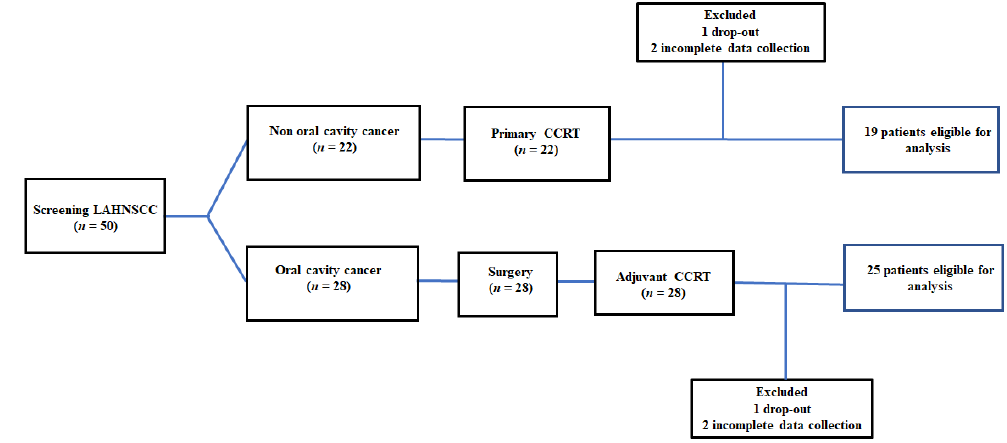
Figure 1. The flow diagram of recruitment: The incomplete CCRT group was defined as (1) patients who dropped out during the treatment course; and (2) incomplete data collection—patients who did not complete the required examinations or missed scheduled tests. LAHNC, locally advanced head and neck cancer; CCRT, concurrent